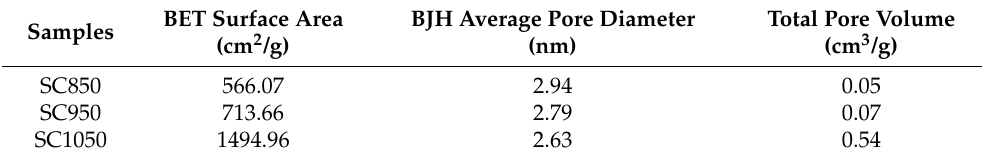
Table 3. Microstructural information of samples SC850, SC950 and SC1050.